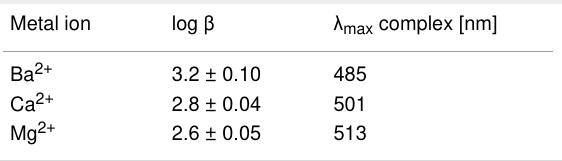
Table 1: Absorption maxima of the complexes with different alkaline- earth metal ions and stability constants of the complexes of 6 in aceto-